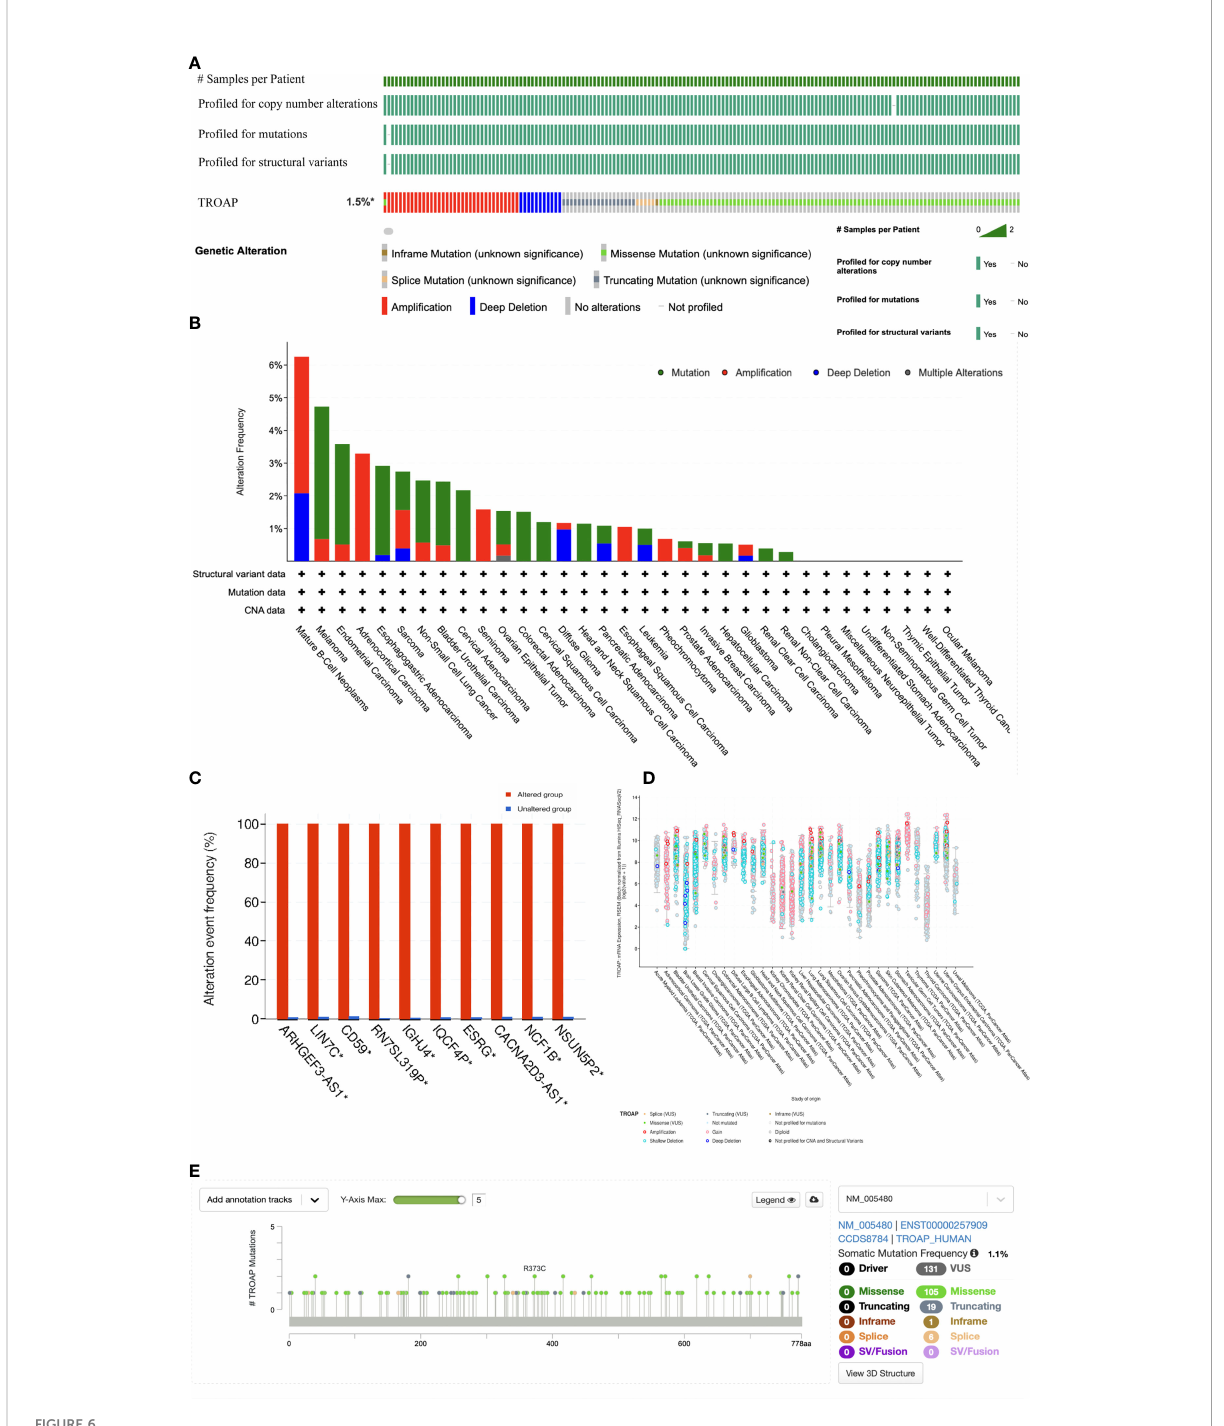
FIGURE 6 The genetic alteration pro fi les of TROAP in pan-cancer from TCGA database analyzed by cBioPortal tool. (A) Summary of the alteration on TROAP gene in pan-cancer: The TROAP gene was altered which accounted for only 1.5% across 10,967 samples via using the cBioPortal database. (B) The alteration frequency of TROAP including structural variant, mutations, and copy-number alterations data in TCGA pan-cancer datasets. (C) The analysis of gene mutation co-occurrence comparing the altered group and unaltered group of TROAP. (D) The major types of TROAP gene alterations in various cancers. (E) The location of main mutation types and corresponding numbers in the site of TROAP amino acid